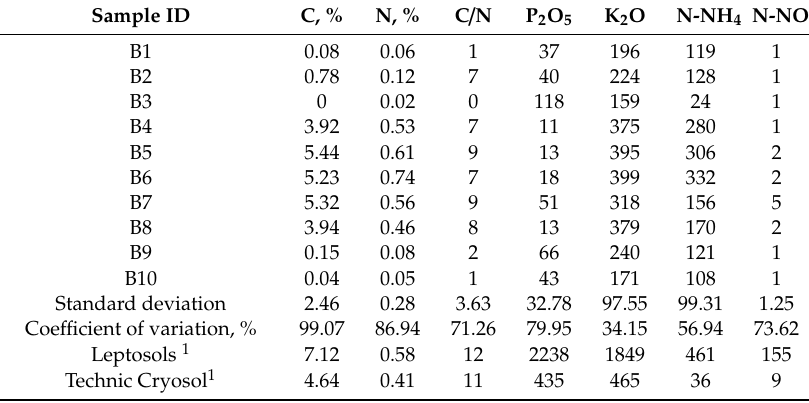
Table 5. The content of nutrients of black carbon (BC) from Collins Ice